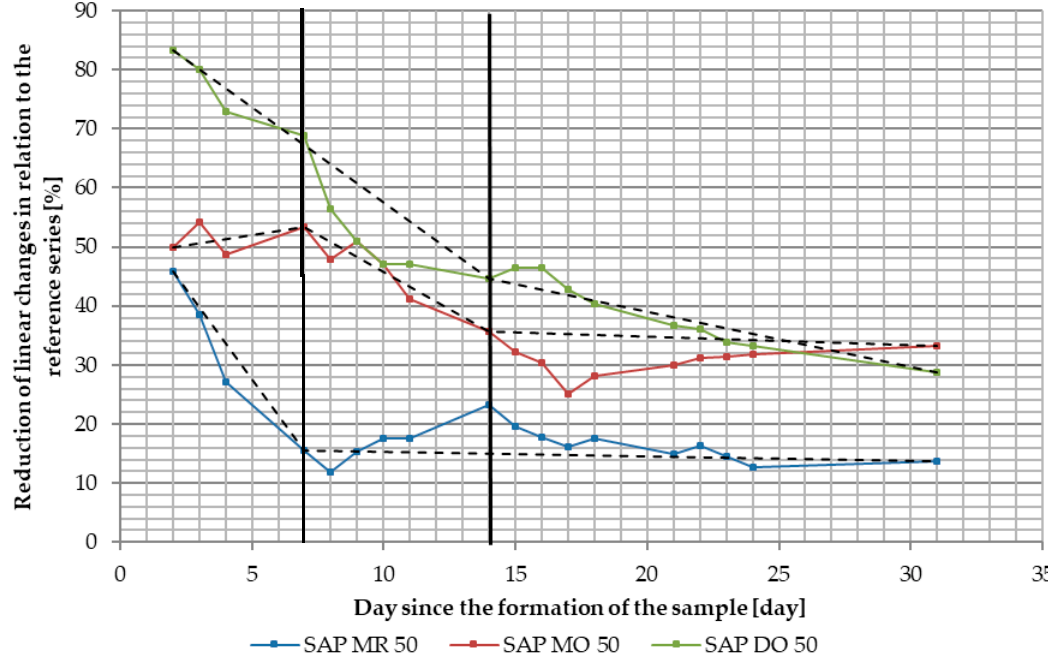
Figure 10. Chart showing the course of changes of the linear changes of tested specimen series of superabsorbent polymers (SAP) (SAP MR 50, SAP MO 50 and SAP DO 50) in relation to linear changes of the reference series ratio at each day of the first month of measurments.